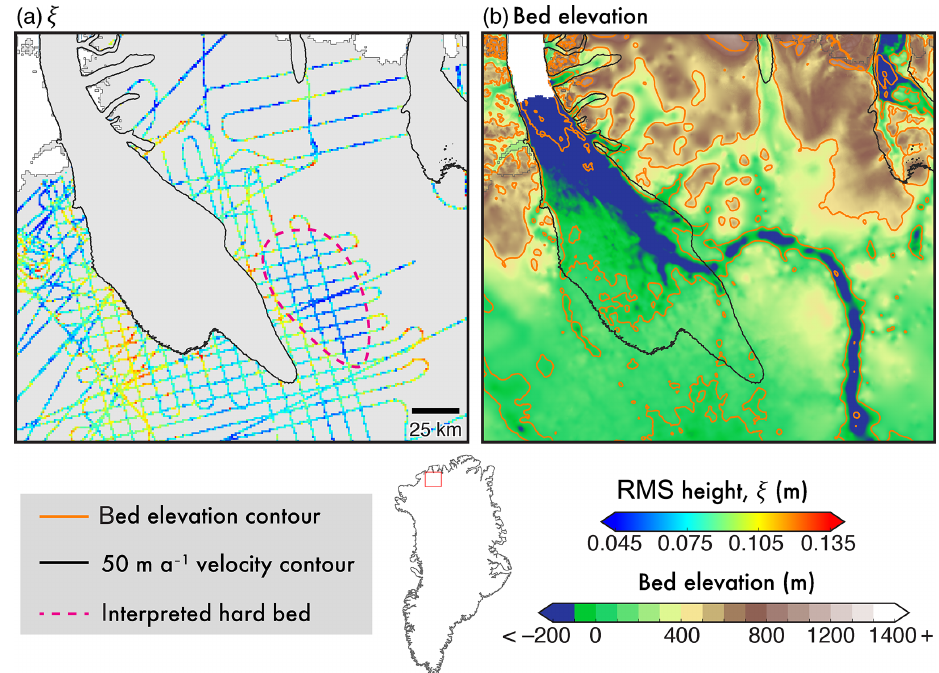
Figure 12. Geological interpretation using scatting-derived roughness, ξ , at Petermann Glacier. (a) ξ , with values in fast-flowing regions (delineated by black contour; | v | > 50ma − 1 ) masked. Interpreted hard bed delineated by pink dashed line. (b) Bed elevation (BedMachine, v3; Morlighem et al., 2017) with contours at 400m intervals. Location inset.